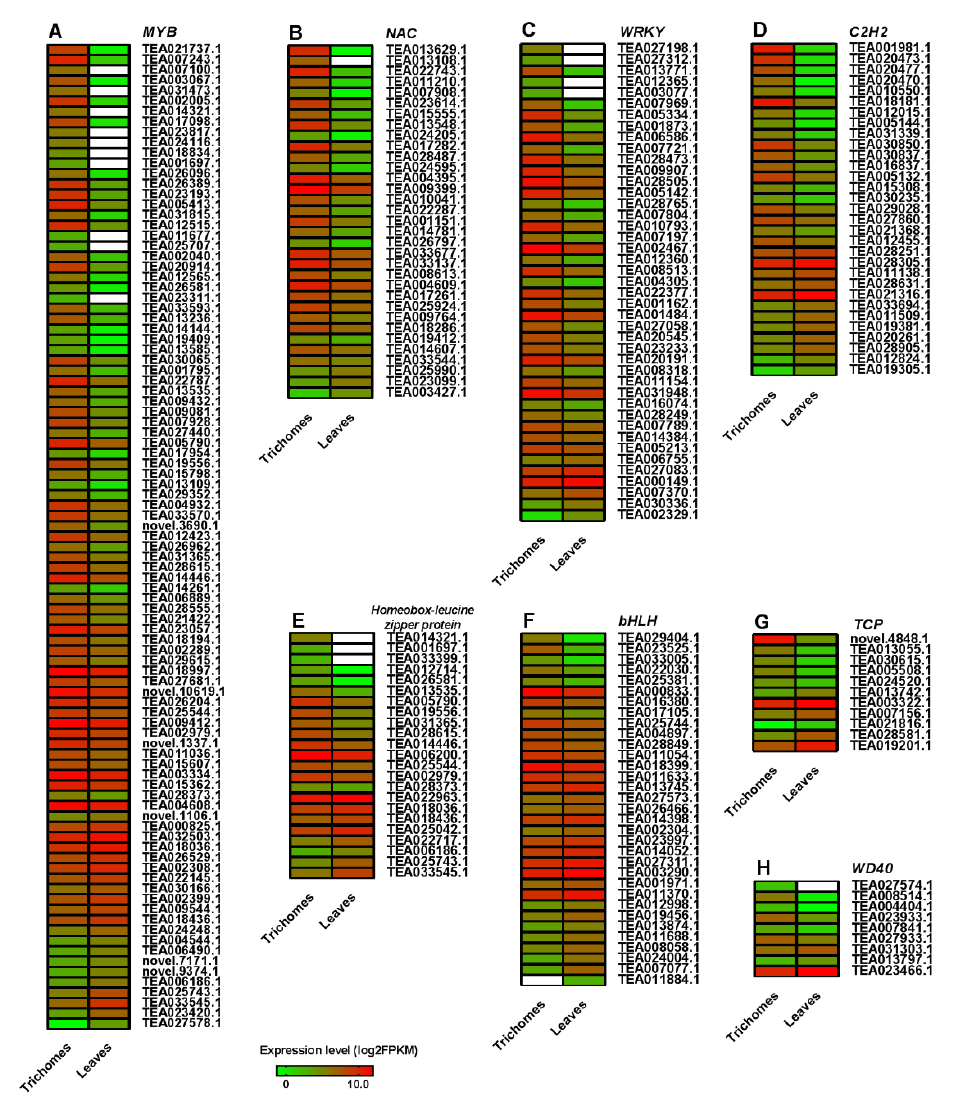
Figure 4. Expression patterns of the main transcription factors in the comparison of trichomes vs. leaves. The significantly expressed transcripts (log 2 FoldChange > 1.0) of MYB ( A ), NAC ( B ), WRKY ( C ), C2H2 ( D ), homeobox-leucine zipper protein ( E ), bHLH ( F ), TCP ( G ) and WD40 ( H ) were identified, and their expression levels in the trichomes and tea leaves are represented by heat maps. The transcripts that were not detected with FPKM values are shown in